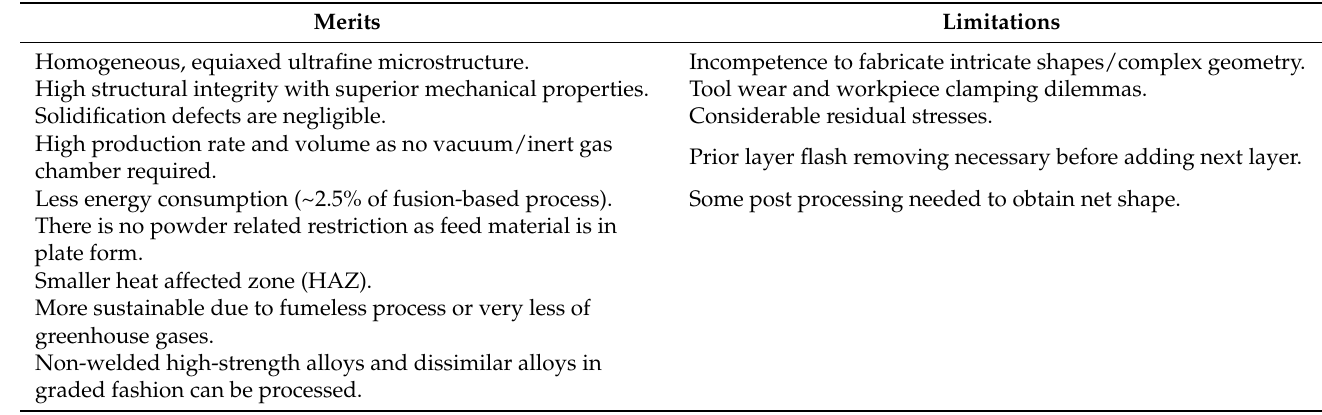
Figure 6. Schematic of stir zones of the FSAM build: ( a ) first pass FSAM; ( b ) second pass FSAM; and ( c ) third pass FSAM (reprinted from [50] with permission from Elsevier).